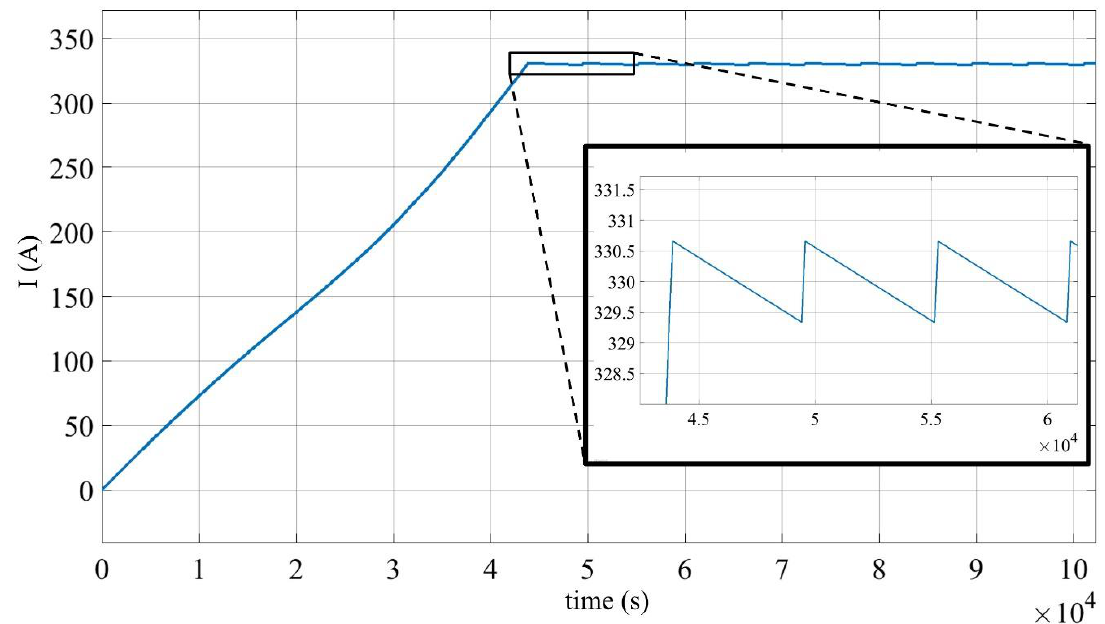
Figure 11. Ramp-up transient and maintenance of current of the EcoSwing field winding supplied by the dynamo flux pump.